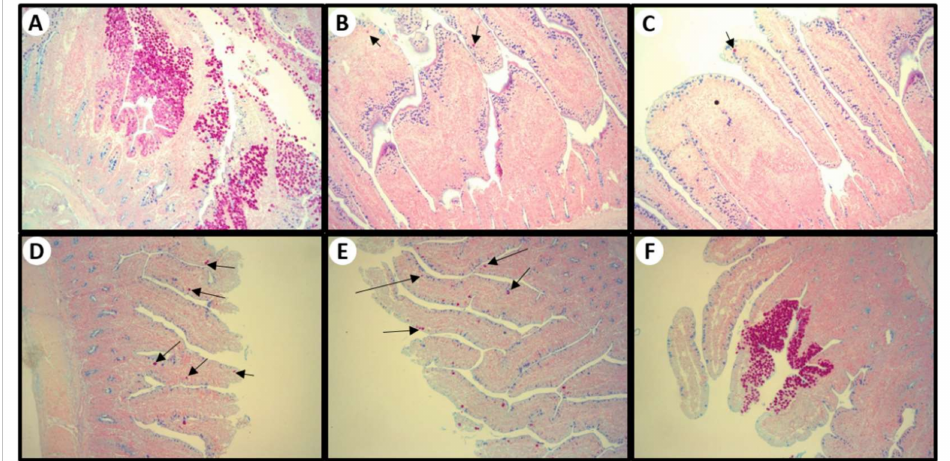
Figure 7. Small intestine stained with Hematoxylin and PAS. ( A ) positive control: intestine show- ing sloughing and desquamation of the intestinal lining and necrosis of the cells and different developmental stages of Eimeria spp. Eimeria oocysts are within the enterocytes of the columnar epithelium. ( B ) Baycox ® (7 mg/kg/day), ( C ) LNCt (7 mg/kg/day), ( D ) LNCt (3.5 mg/kg/day), and ( E ) (1.75 mg/kg/day): intestine showing mild degree of Eimeria spp. (arrows). ( F ) LNC (vol- ume equivalent to LNCt 7 mg/kg/day): intestine showing severe contamination by Eimeria spp. Magnification, 100 ×